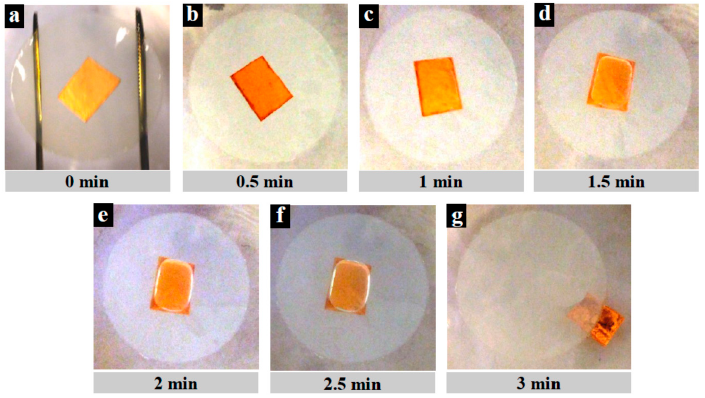
Figure 12. Copper/graphene and PVDF 1 substrate detachment process during copper etching step in transfer process, ( a ) Cu/graphene attached to substrate and floated over APS etchant; ( b ) after 30 s, etchant starts to penetrate between copper/graphene and substrate from the edges (dark regions); ( c ) after 60 s; ( d ) air bubbles become entrapped between Cu/graphene and the substrate; ( e ) after 2 min, air bubble becomes enlarged ( f ) air bubble tries to cover the entire attachment area; ( g ) Cu/graphene and substrate detachment is completed.